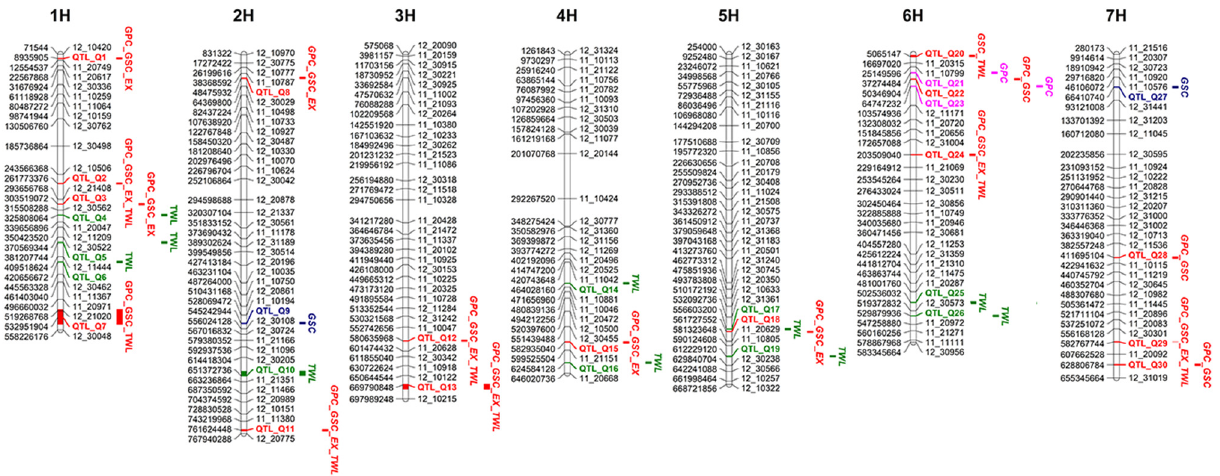
Figure 5. The location of QTLs associated with barley grain quality traits on the genetic map. The names of SNPs and QTLs are shown on the right, and the positions of the loci are shown on the left of the linkage maps as base pairs (bp). The QTLs identified in this study are highlighted in blue for grain starch content, pink for grain protein content, green for grain test weight, and red for multi-trait QTLs. GPC—grain protein content; GSC—grain starch content; EX—extractivity; TWL—grain test weight.